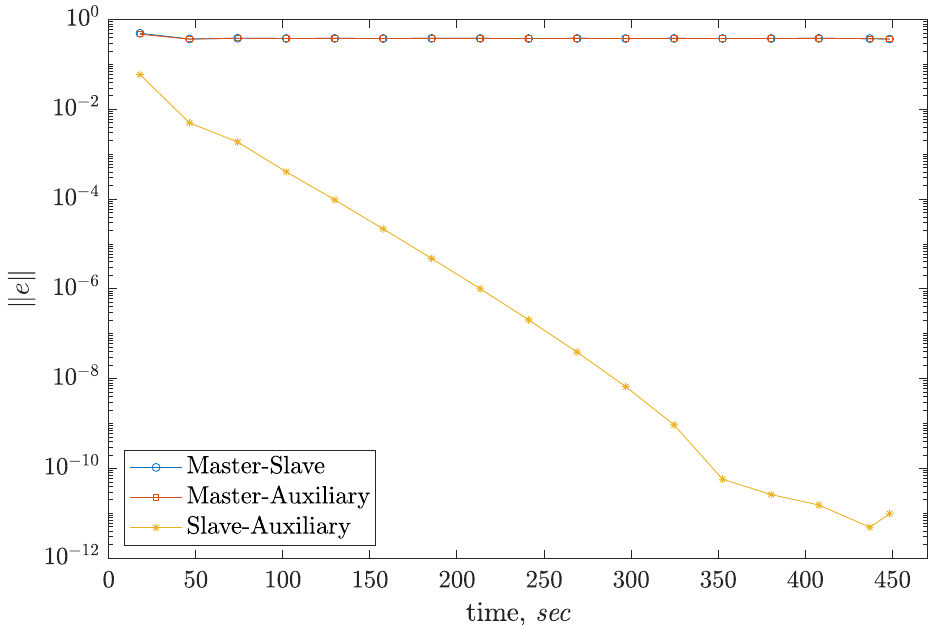
Figure 10. Synchronization error between computer models simulated by Heun’s method. Time sequences are smoothed with a median filter; the window size is 200 samples.